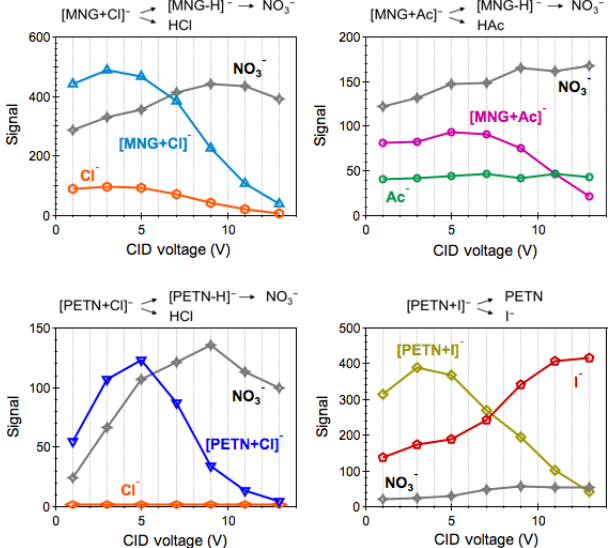
Figure 5. Peak intensities of the precursor ion adducts [MNG + Cl] − , [MNG + Ac] − , [PETN + Cl] − and [PETN + I] − as well as their fragment ions as a function of the collision energy as displayed by the CID